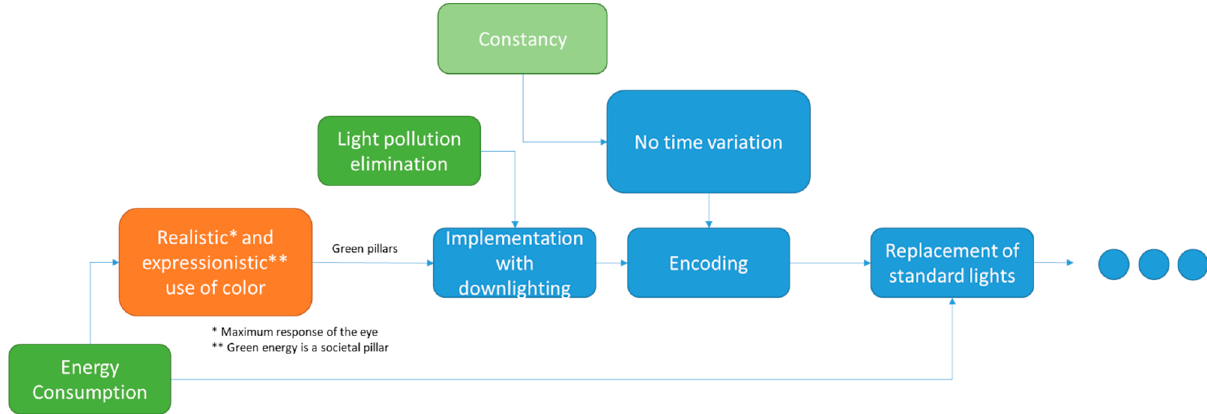
Figure 39. Energy and light pollution limitation working diagram. The end of the diagram has been deliberately omitted.